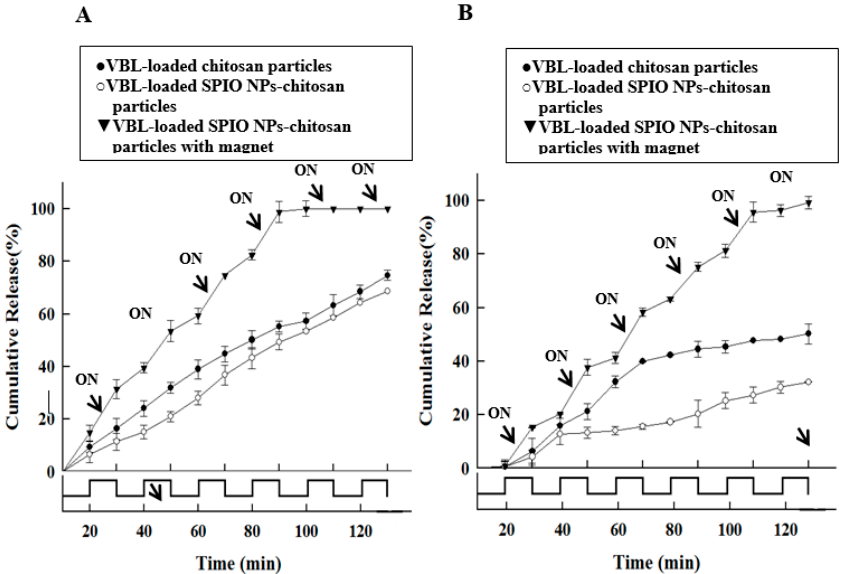
Figure 8. The effect of polymer molecular weight (MW) on drug release patterns, and with or without pulsatile magnetically triggered tests of VBL-loaded SPIO NPs–chitosan composite particles in PBS (pH 7.2). The ( A ) is using 150,000 MW chitosan and ( B ) is using 400,000 MW chitosan.